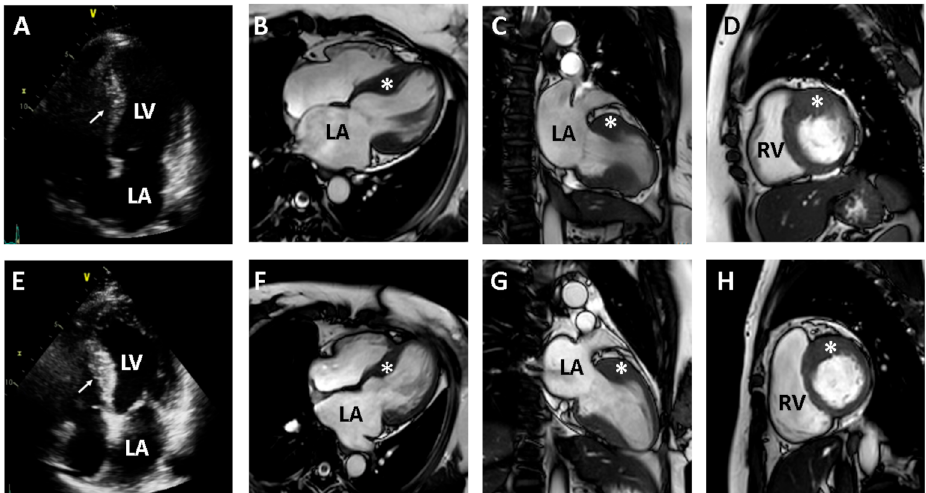
Figure 2. Two-dimensional echocardiography and contrast-enhanced cardiac magnetic resonance (CMR) images from the proband’s daughters with hypertrophic cardiomyopathy (HCM) (second daughter in upper panel and fourth daughter in lower panel). Two-dimensional echocardiography reveals the hypertrophy of the ventricular septum in each daughter (( A ) in second daughter and ( E ) in fourth daughter). CMR images clearly demonstrate segmental hypertrophy (asterisk) confined to the ventricular septum, consistent with a diagnosis of HCM (( B – D ) in second daughter and ( F – H ) in fourth daughter). LA, left atrium; RA, right atrium; LV, left ventricle; RV, right